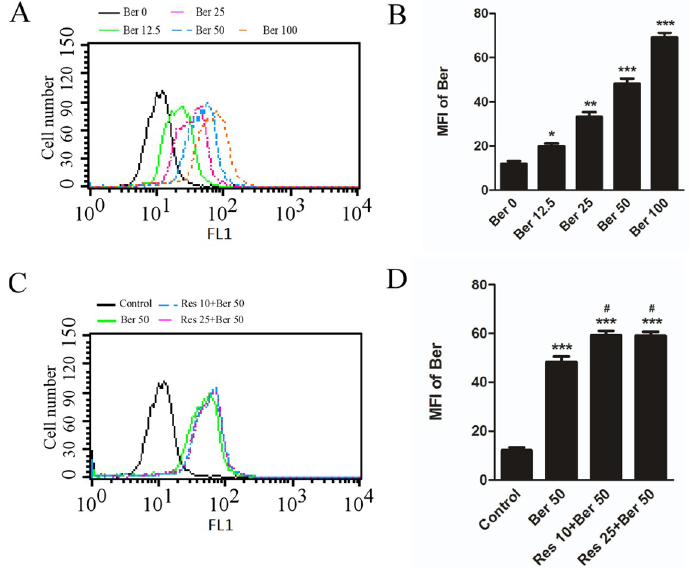
Figure 3. Intracellular accumulation of Berberine enhanced by Res in Hepatic L02 cells. ( A , B ) intracellular fluorescence of Ber in a dose-dependent manner (0–100 µ mol/L), and mean fluorescence intensity (MFI) calculated and compared in different dose of Ber groups. *** p < 0.001, ** p < 0.01, * p < 0.05 vs. untreated control. ( C , D ) Res at 10 or 25 µ mol/L added in advance (details indicated in Material and Methods) enhanced intracellular fluorescence of Ber at 50 µ mol/L, MFI calculated and compared, *** p < 0.001 vs. untreated control, # p < 0.05 vs. single Ber treatment. Data shown are representative of three separate assays.